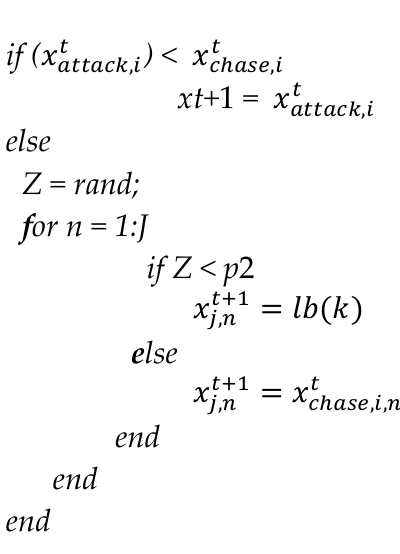
Figure 5. Pseudocode for position updating using OPA.